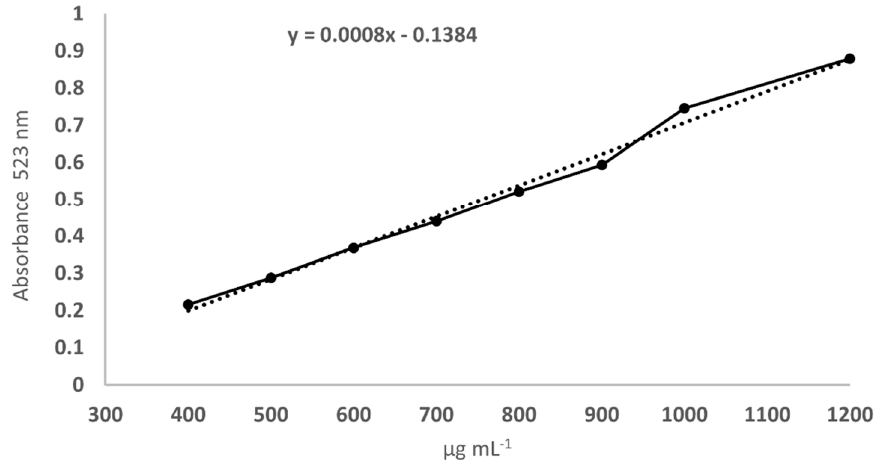
Figure 1. Calibration curve for Congo red method and its equation.